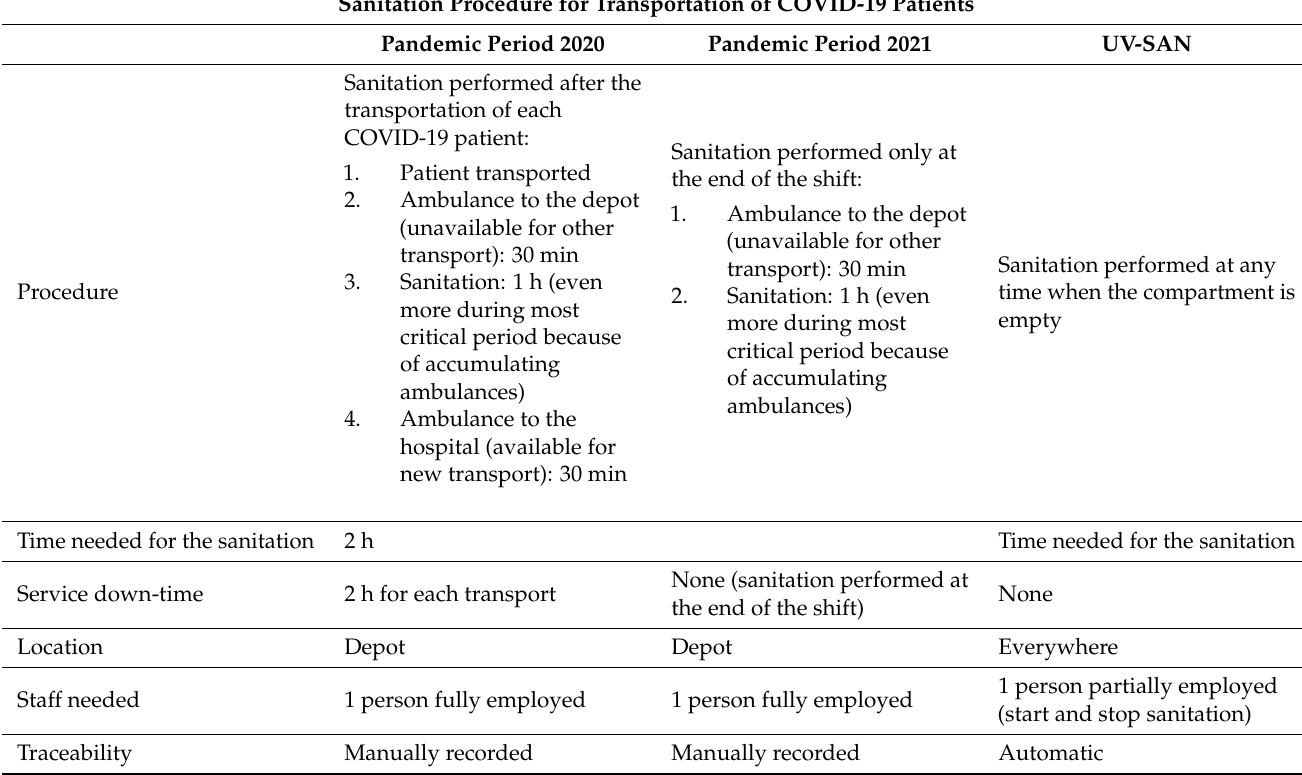
Table 5. Comparison between sanitation procedures. Sanitation Procedure for Transportation of COVID-19